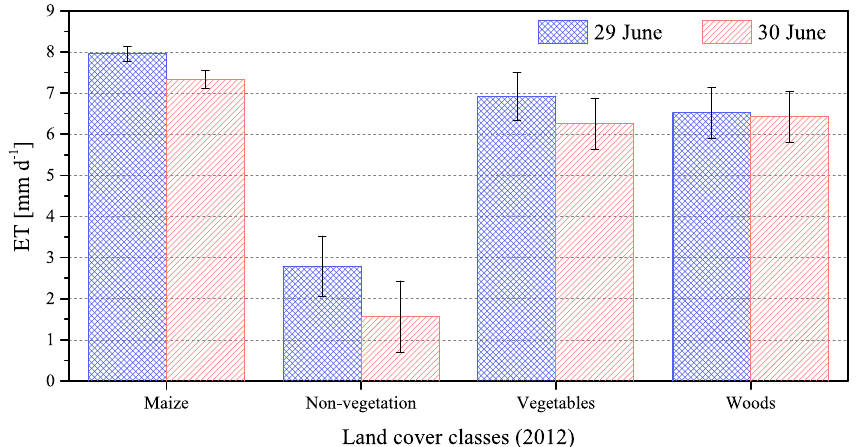
Figure 8. The disaggregated daily ET for each land-cover class in the kernel experimental area of HiWATER on 29 and 30 June 2012; the error bar is the standard error of ET estimates in the regression. Table 4. ET for each land-cover class and their proportion of the kernel experimental area